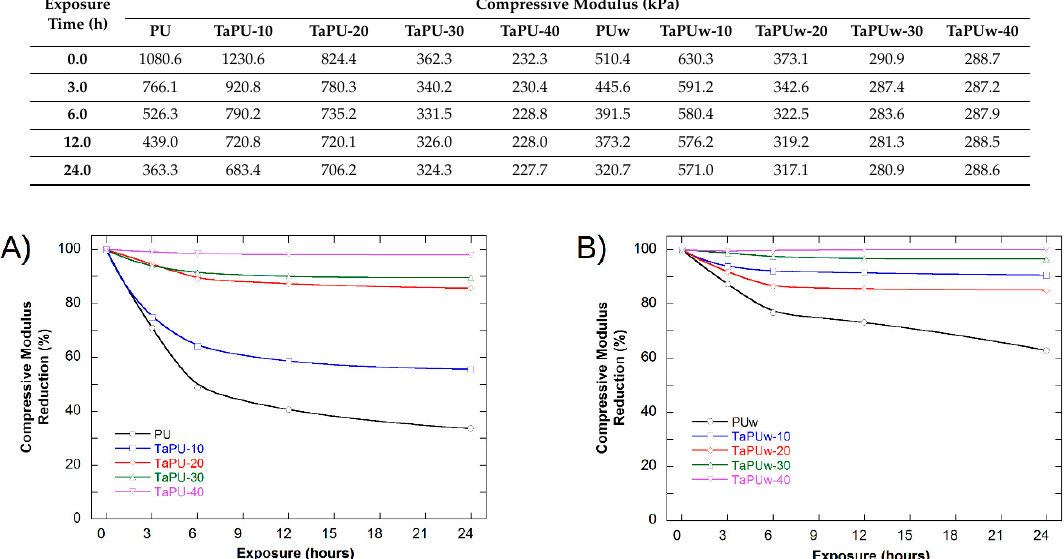
Figure 11. Variation of the critical strain as a function of UV exposure time: ( A ) without added water; ( B ) with added water. (The solid lines are shown to guide the eyes.)